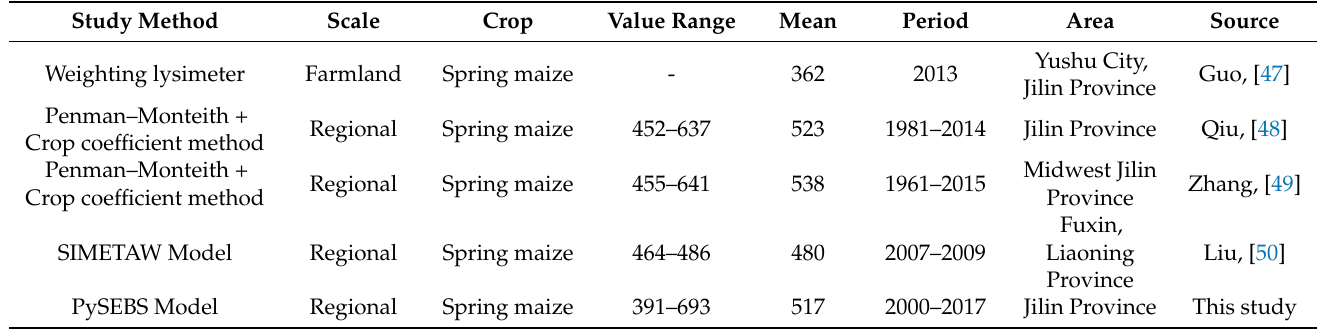
Table 2. Comparison of the PySEBS estimated spring maize ET a with similar studies (unit: